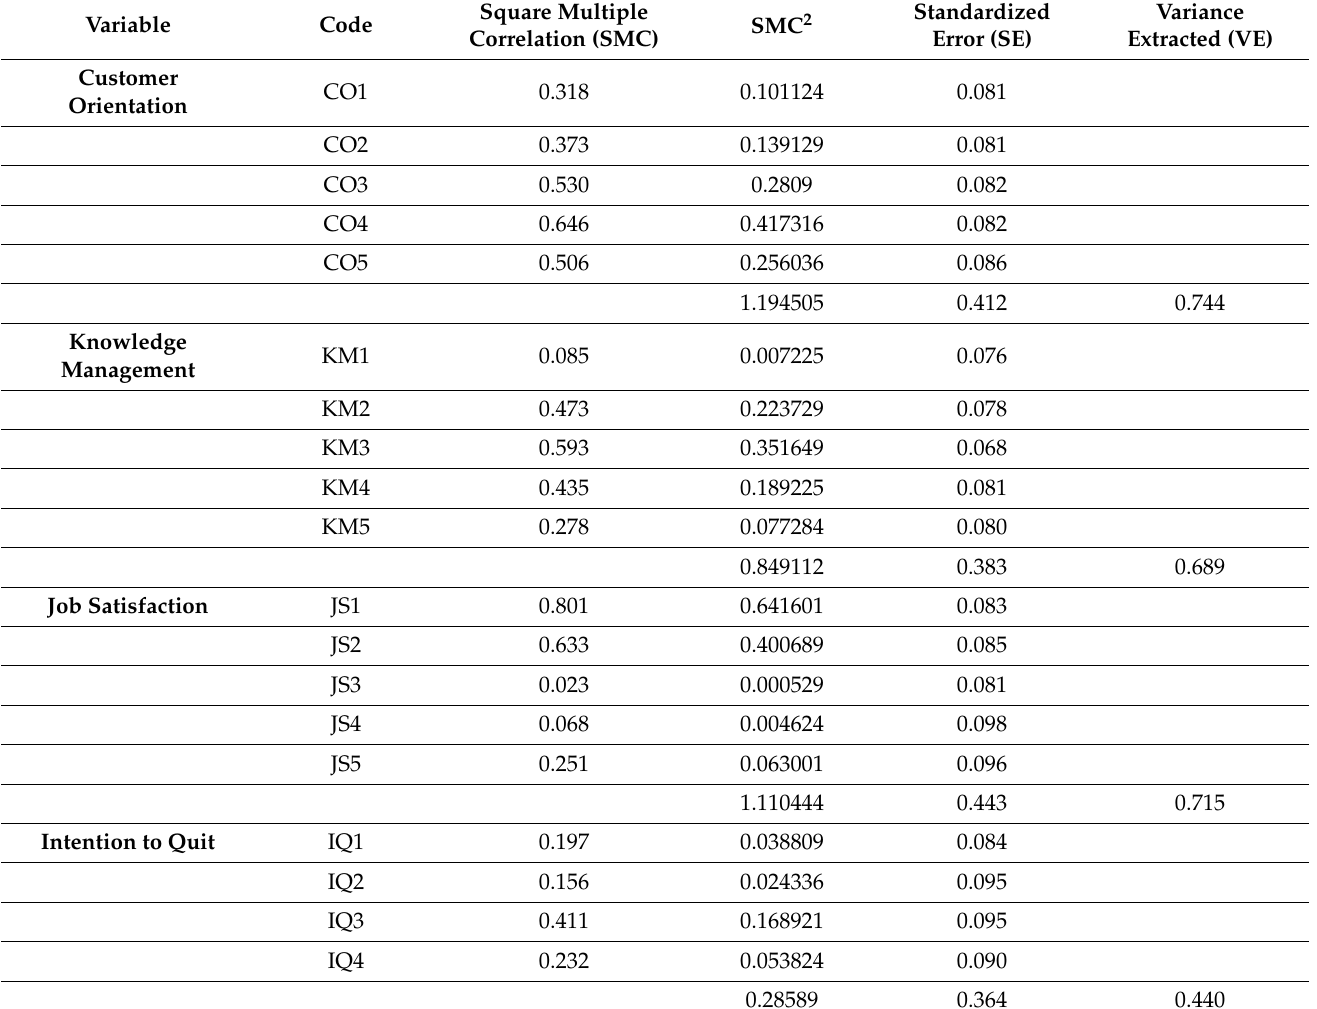
Table 3. Variance extracted.